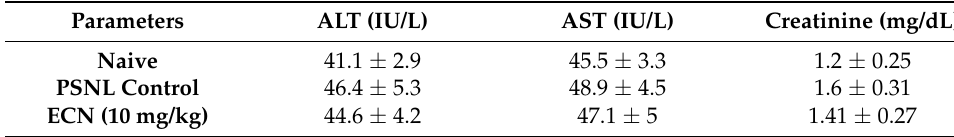
Table 1. Effect of PSNL on liver and kidney